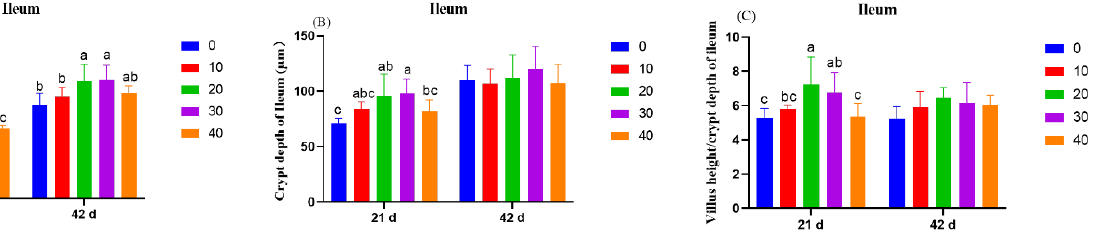
Figure 2. Effects of dietary 1,8-cineole supplementation on ileum morphology of broiler chickens: ( A ) villi height; ( B ) crypt depth; ( C ) villi height/crypt depth. a,b,c,d Means within a row with different superscripts are significantly different ( p < 0.05).